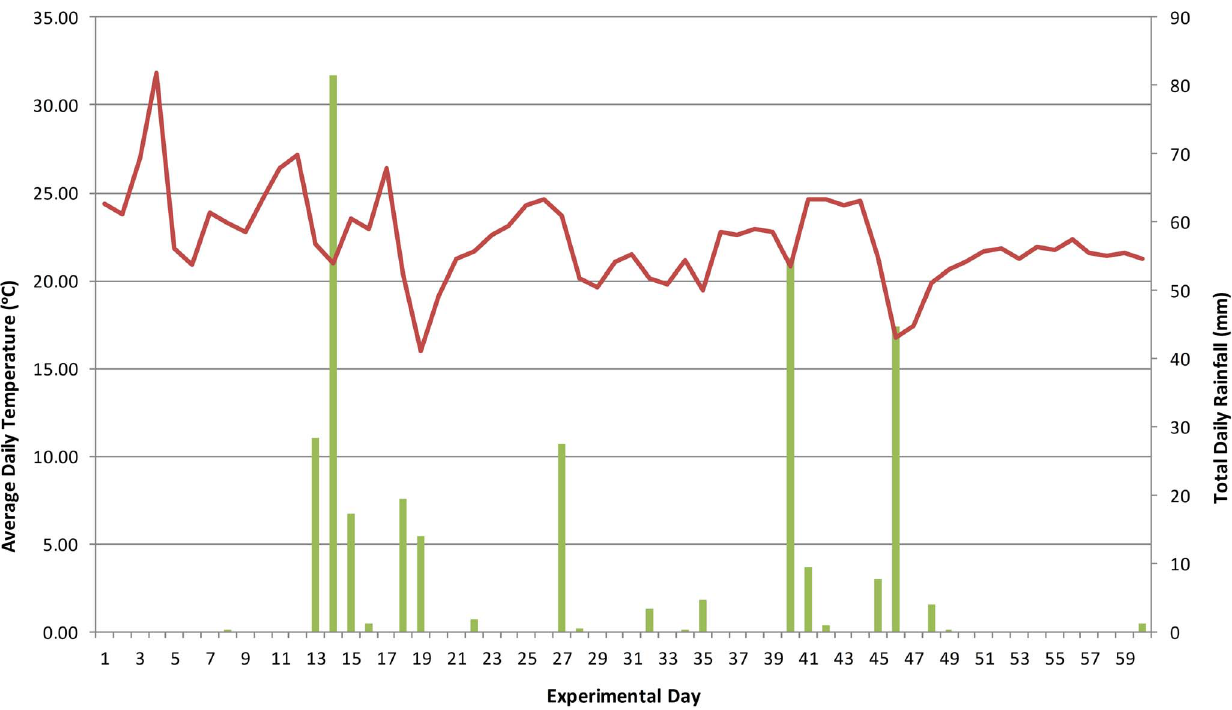
Figure 2. Average temperature and rainfall data for the study site (January - March, 2013).